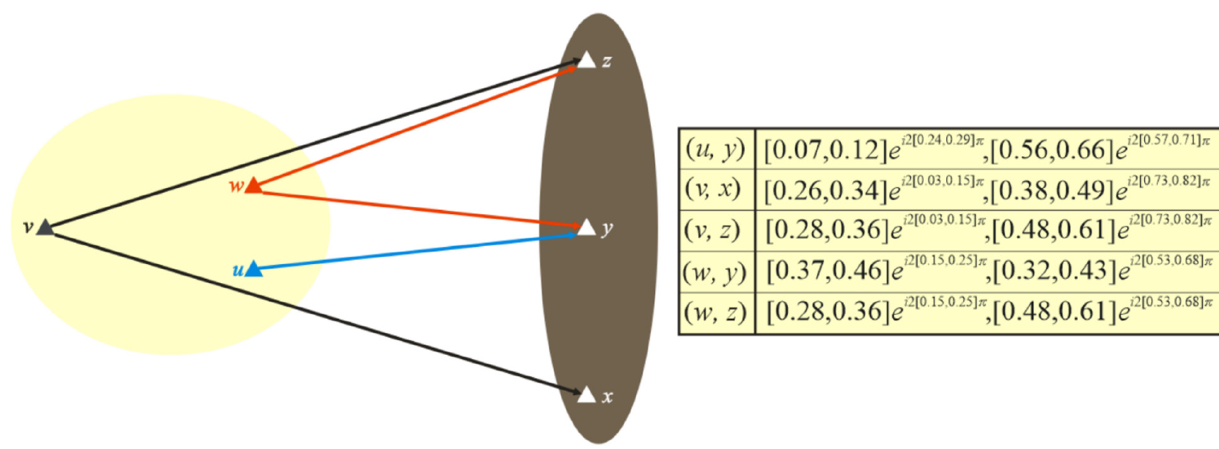
Figure 1. Interval-valued complex intuitionistic fuzzy relation.